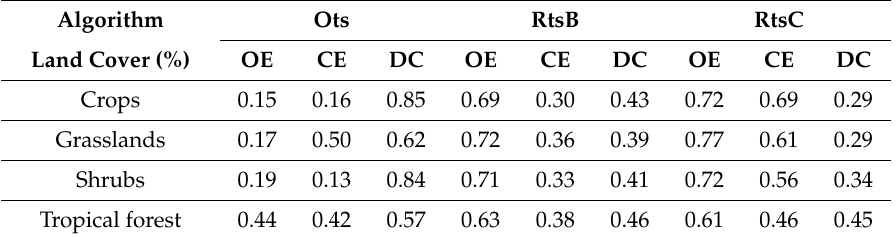
Table 4. Agreement between reference and detected burned areas by land cover type using a common confusion matrix formed by all pixels from the 10 tiles analysed.